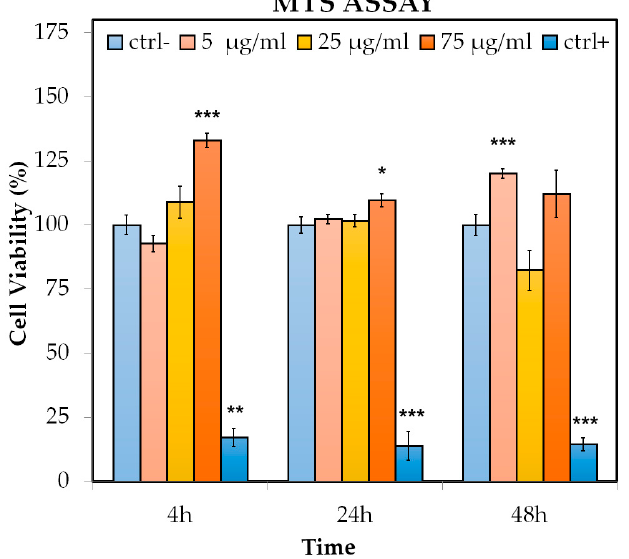
Figure 2. MTS [3-(4,5-dimethylthiazol-2-yl)-5-(3-carboxymethoxyphenyl)-2-(4-sulfophenyl)-2H- tetrazolium] test in Hs27 cells: the effects of polystyrene nanoparticles (PNPs) on cell proliferation were evaluated following exposures at 4, 24, and 48 h at 5, 25, and 75 μ g/mL concentrations and compared to the control cells. Triton-X-100 0.1% was used as a positive control. Significance values * = p < 0.05; ** = p < 0.005; *** = p < 0.0005; error bars represent the standard error of the mean.